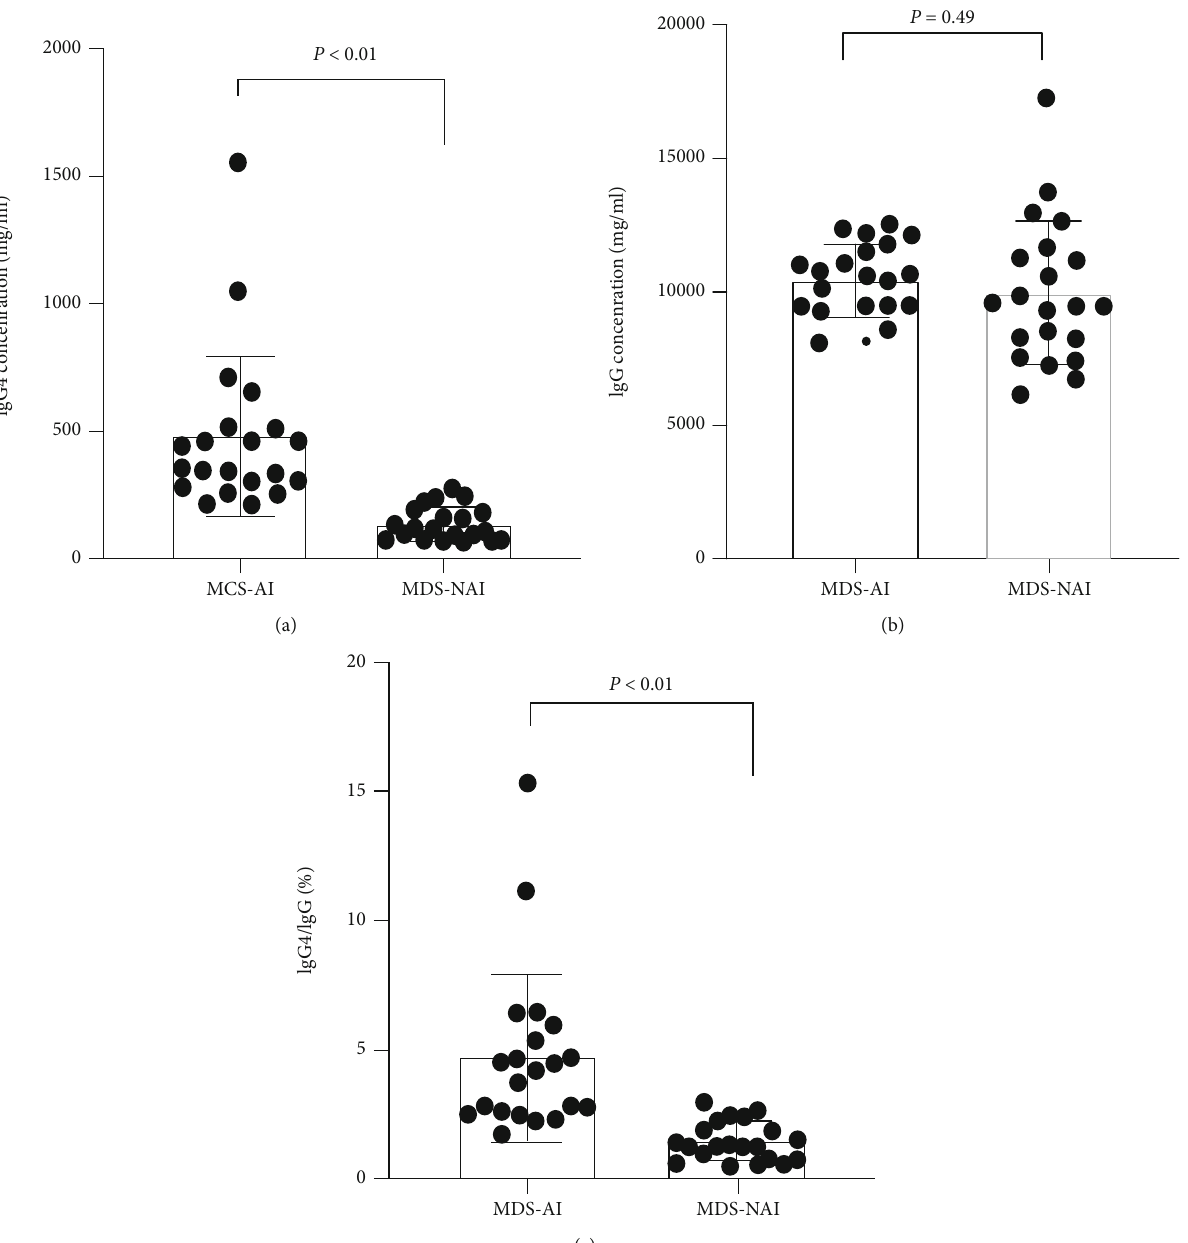
Figure 2: Elevated levels of IgG4 in serum from newly diagnosed MDS-AI. (a) The level of IgG4 in serum from newly diagnosed MDS- AI ( N = 21 ) and MDS-NAI ( N = 21 ). (b) The level of IgG in serum from newly diagnosed MDS-AI ( N = 21 ) and MDS-NAI ( N = 21 ). (c) The ratio of IgG4/IgG in serum from newly diagnosed MDS-AI ( N = 21 ) and MDS-NAI ( N = 21 ). The bars represent the standard error of the